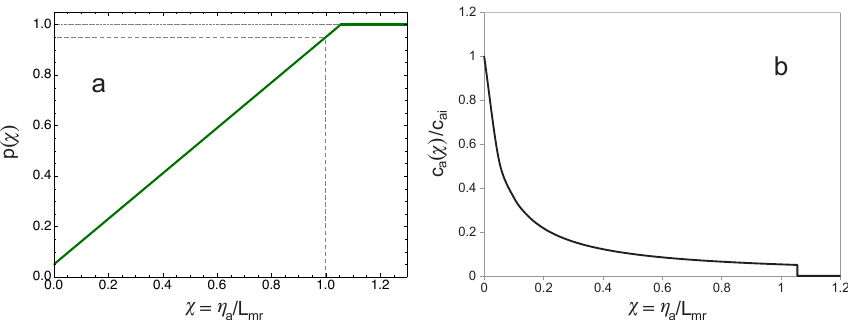
Figure 7. (a) Simplest modified form the MRSAA cover function (green curve) satisfying the conditions p( 0 ) = r , p (1) = 1 − r and p( ∞ ) = 1, where in this case r = 0.05. The parameter on the vertical axis p(χ) denotes the cover fraction, and the parameter on the horizon- tal axis is χ = η a /L mr , where η a is the thickness of alluvium and L mr is the macro-roughness height. (b) Plot of the ratio of alluvial wave speed c a (χ) at a finite value of χ = η a /L mr to the corresponding speed c ai for an alluvial wave of infinitesimal height versus χ . The plot shows that alluvial wave speed declines with increasing alluvial thickness, and that it vanishes under complete